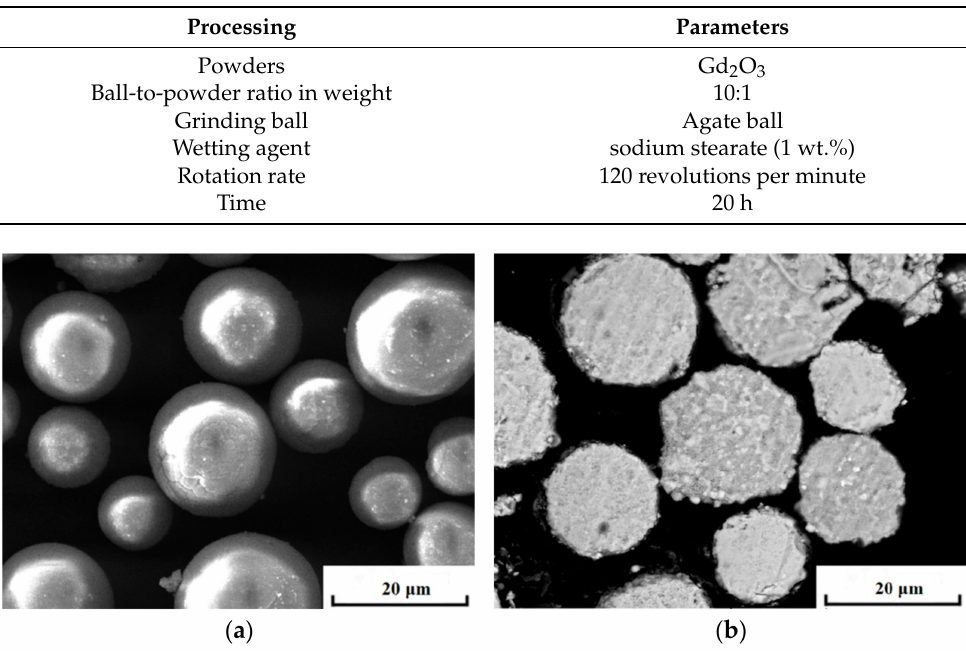
Figure 1. Globular morphology of Gd 2 O 3 powders ( a ); Cross-sectional microstructure of Gd 2 O 3 powders ( b ). Table 2. Parameters of isostatic press and